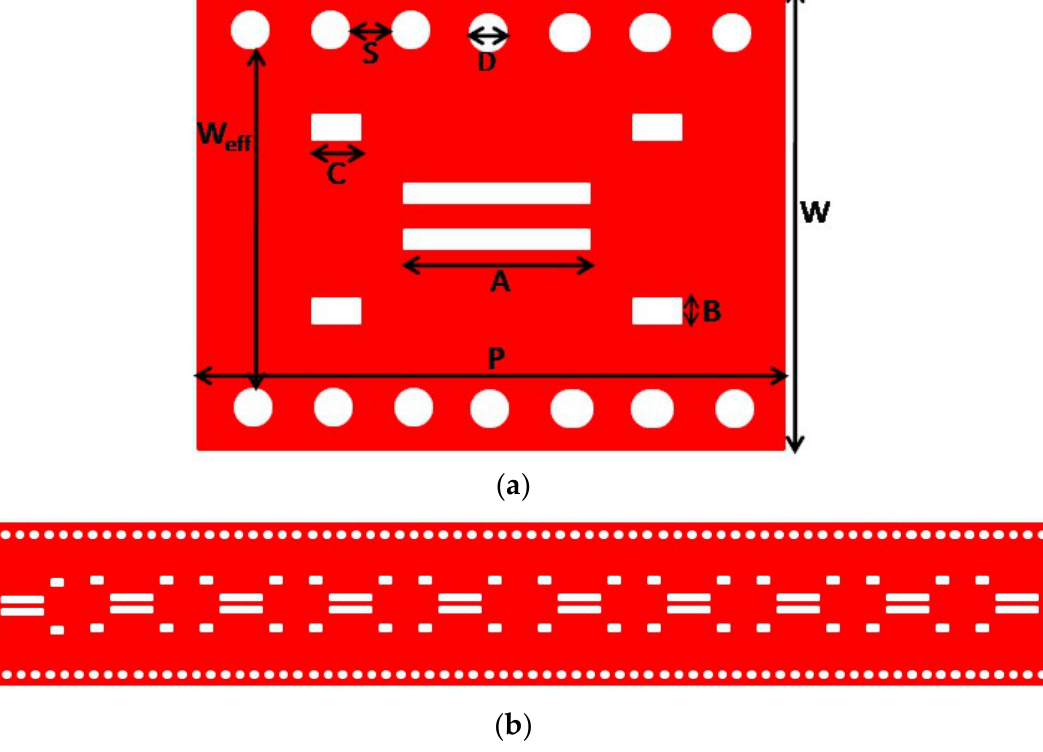
Figure 1. ( a ) Unit cell for SIW LWA; ( b ) Structure of SIW LWA. The two parallel rectangular slots in unit cell having length equal to λ g /4. The normalized phase constant is shown in Figure 2 using Equation